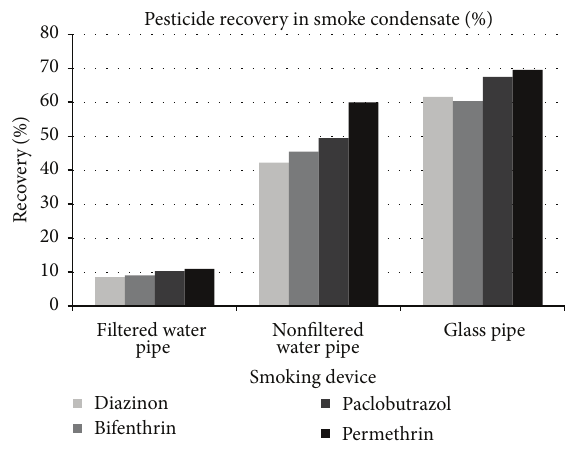
Figure1:Percentrecoveryofpesticidesfromthesmokestreamfrom each